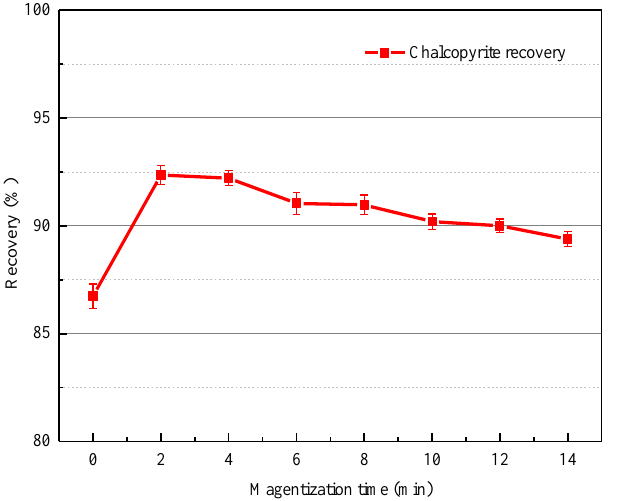
Figure 5. The relationship between the magnetization time and the recovery of chalcopyrite.